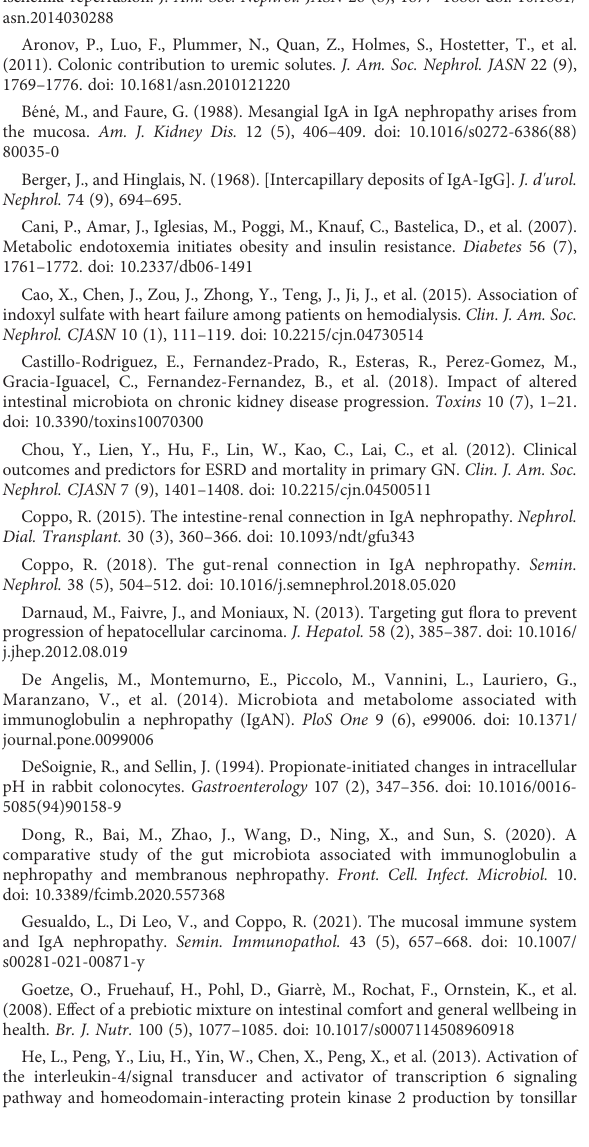
genera were signi fi cantly enriched in IgAN. The POD value was signi fi cantly decreased in IgAN versus n_IgAN in the training phase (F) , test phase (G) . PCA, Principal Components Analysis; LDA, Liner Discriminant Analysis; LEfSe, the LDA Effect Size; POD, probability of disease. SUPPLEMENTARY TABLE 1 Comparison of gut microbiota richness and evenness among three groups. Used the Mann-Whitney U test for pairwise comparisons of alpha diversity among three groups, the results were presented using the median [IQR]. IQR, interquartile range; HC, healthy controls; IgAN, immunoglobulin A nephropathy; n_IgAN, non-immunoglobulin A